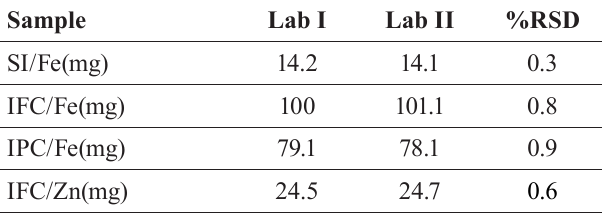
TABLE X - R eproducibility studies on Microwave digested dietary supplements from two different laboratories Sample